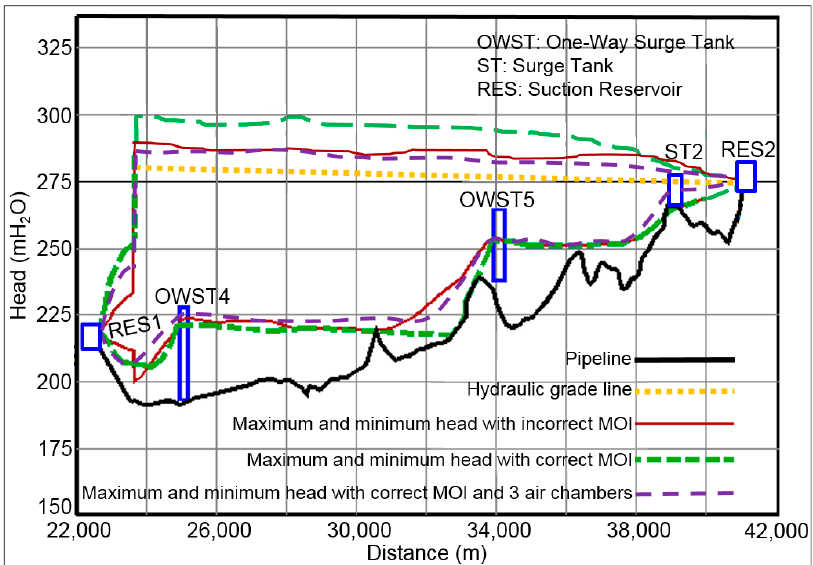
Figure 4. Maximum and minimum head envelopes for the second pipeline segment, considering the incorrect moment of inertia (original design), the correct moment of inertia (MOI), and the correct moment of inertia and the three additional air chambers, following the simultaneous power failure of the five pumps at Pumping Plant 2.